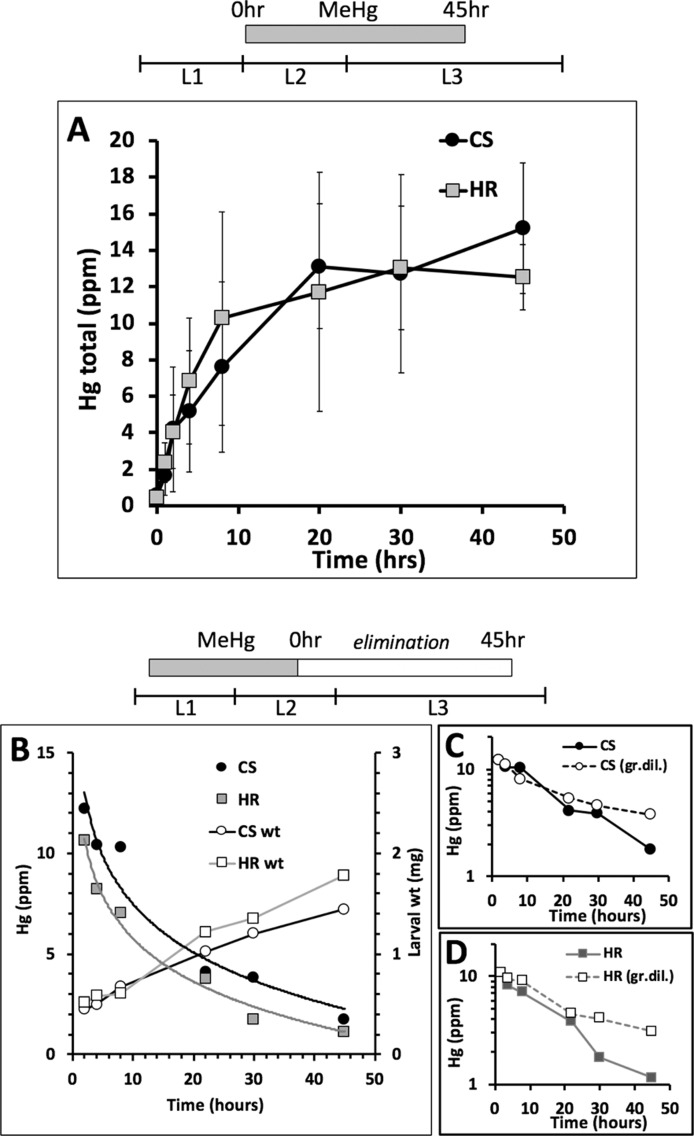
Rate of MeHg uptake and elimination. (A) Uptake of MeHg (5 μM in food) was initiated with early L2 larvae of Canton S (CS) and Hikone R (HR) strains and carried out for 45 h. Larvae were sampled at various time points for total Hg analysis (n = 3 replicates of pooled samples of 15 larvae/time point). (B–D) Elimination of MeHg was determined in larvae previously exposed to MeHg for 40 h starting at the early L1 stage. MeHg elimination was initiated by transferring L2 larvae to MeHg-free food. (B) Larvae were sampled at various time points (10 L3 larvae/time point) for total Hg analysis. Results from one of two trials is shown (see trial 2 in
Figure S2
). Larval weights (wt) are also plotted for each time point. (C, D) Semi-log plots of Hg versus time for CS (C) and HR (D) including predicted profile of Hg concentration over time based on growth dilution alone (dashed line, gr.dil).